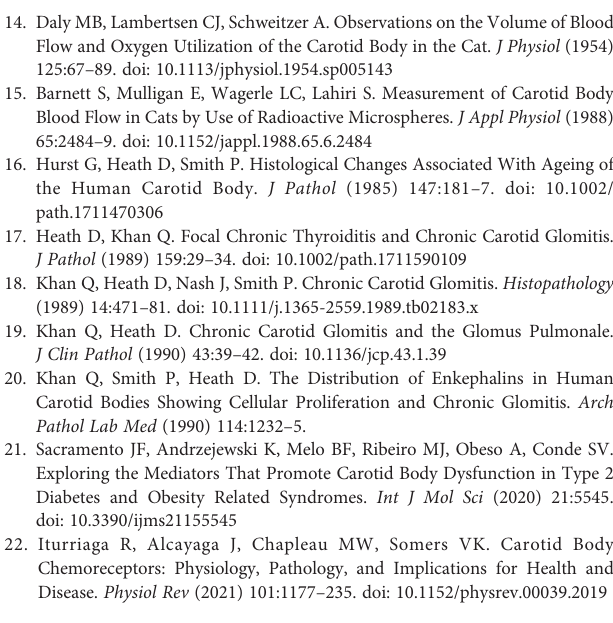
Supplementary Figure 2 | LeftcarotidbodyofCase1 – Haematoxylin-eosin (A) and immunohistochemitriesforCD61( B ;arrow: fi brin/plateletmicrothrombosis),nucleocapsid (C) , Spike (D) , CD68 (E) and CD3 (F) . Scale bars: 100 µm (A, B) ; 50 µm (C – F) . Supplementary Figure 3 | Left carotid body of Case 3 – Haematoxylin-eosin (A) andimmunohistochemitries fornucleocapsid (B) ,Spike (C) ,CD68 (D) , CD3 (E) and CD20 (F) . Scale bars: 100 µm (A, F) ; 50 µm (B – E).